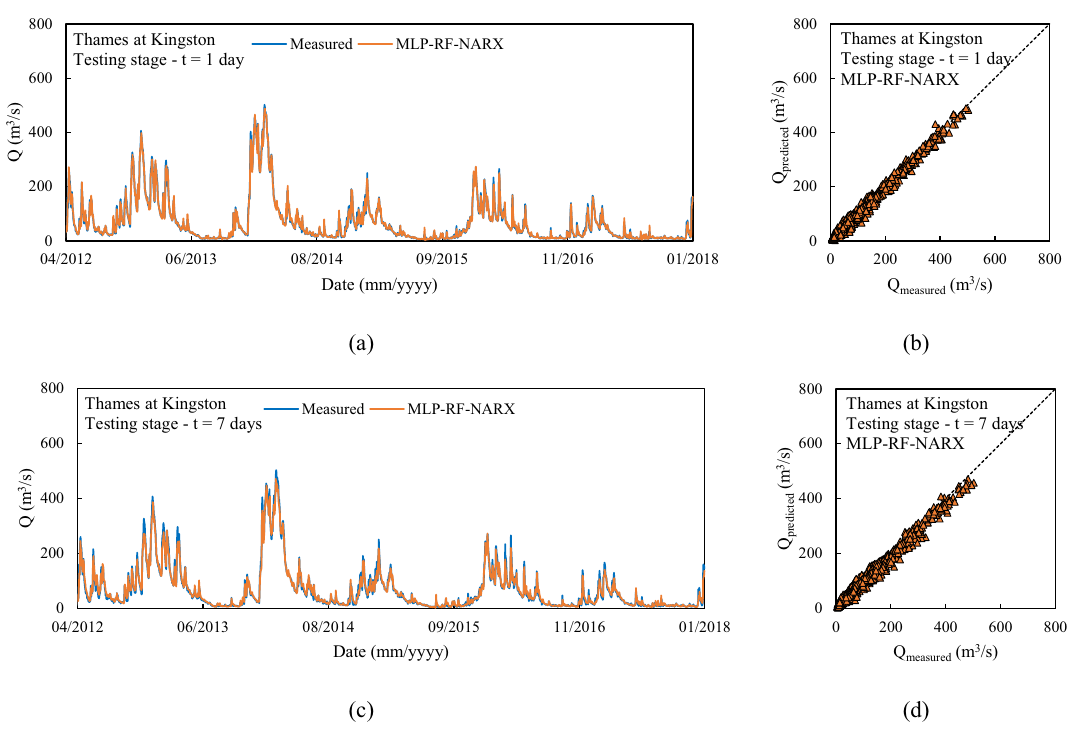
Figure 10. Predictions for the Thames at Kingston with MLP-RF-NARX model: t = 1 day ( a , b ); t = 7 days ( c , d